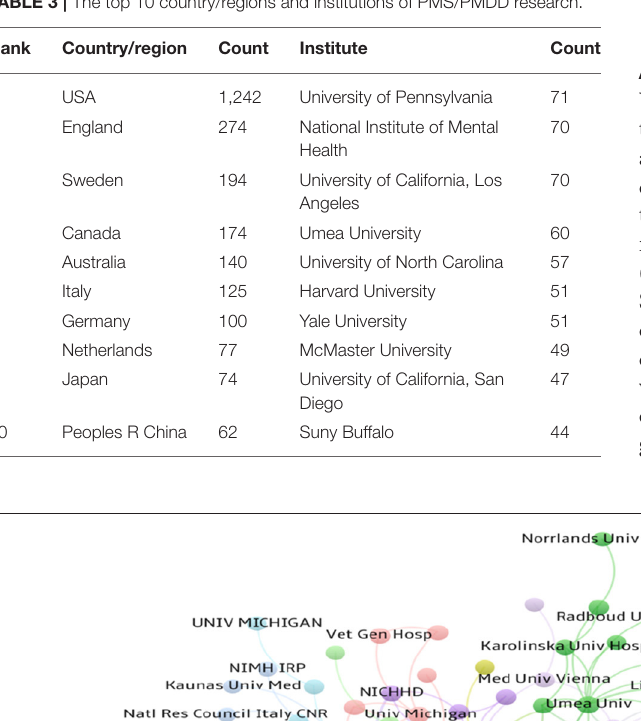
TABLE 3 | The top 10 country/regions and institutions of PMS/PMDD research.